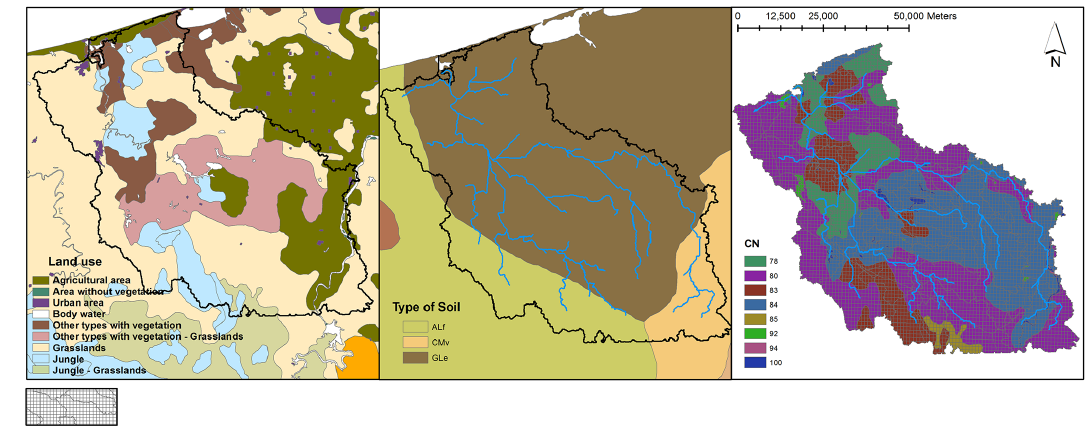
Figure 5. Input data parameters in the hydrological model; (a) land use; (b) pedology; (c) river network, curve number and grid.